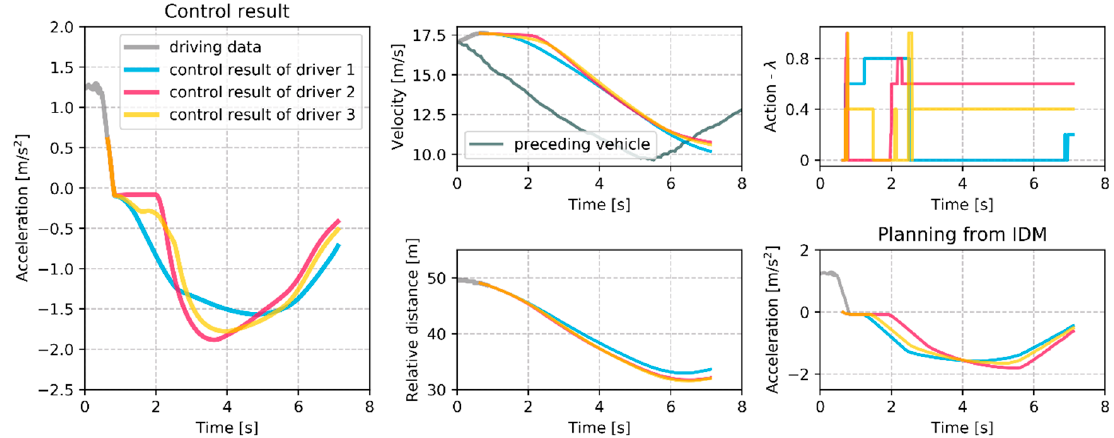
Figure 19. Regenerative control results depending on the individual driver.